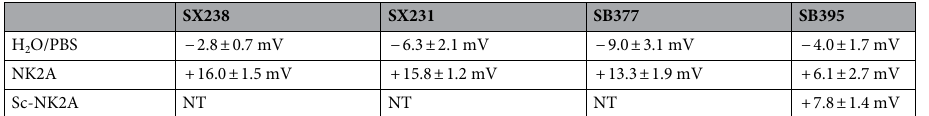
Table 3. Zeta potential of MDR and non-MDR Salmonella outbreak isolates before and after 2 µM NK2A and Sc-NK2A treatments for 20 min. NT not